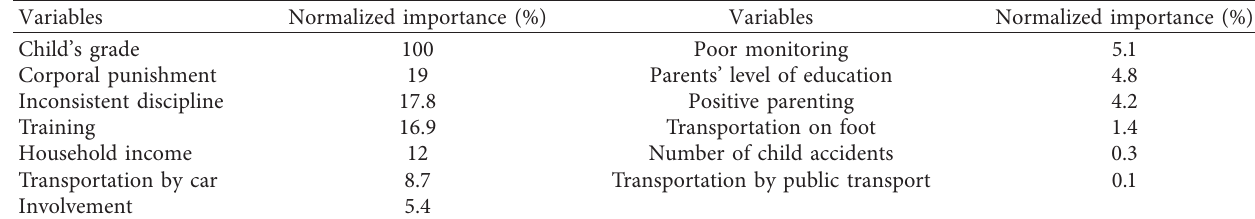
Figure 5: Decision tree of the informative sign model (test data). Table 11: Variable significance of the informative sign model.